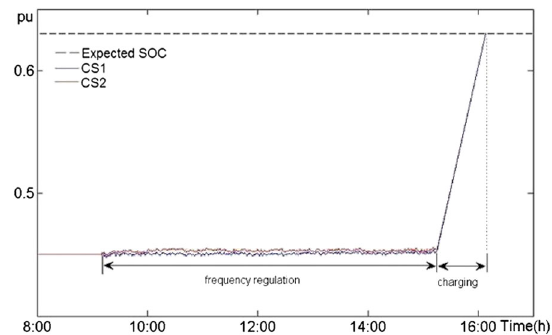
Fig. 13 Real-time battery SOC levels of an EV for CS1 and CS2